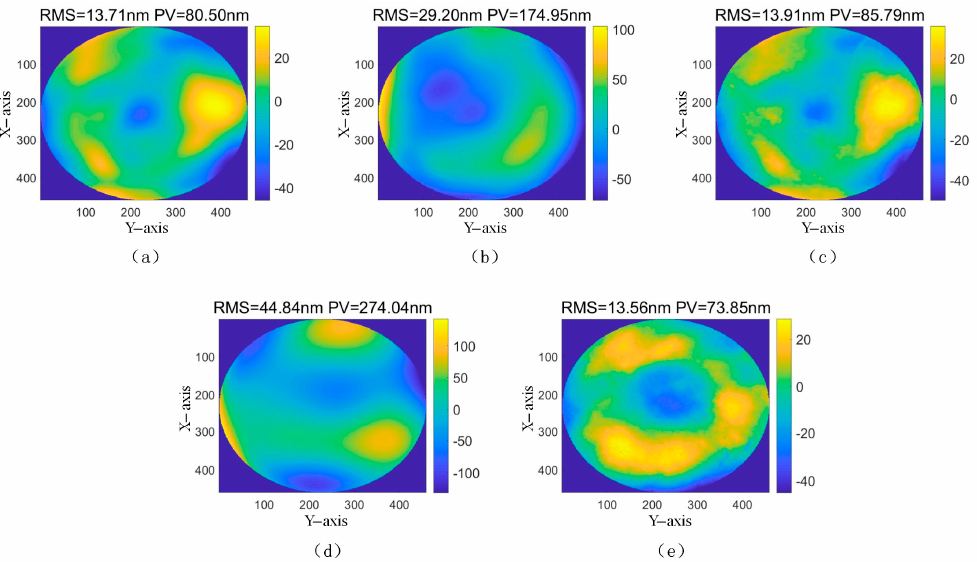
Figure 10. Experiment results of the optical planar element (after removing the first six terms): ( a ) EPCM; ( b ) PM with systematic errors; ( c ) PM after eliminating systematic errors; ( d ) MPMD; ( e ) Interferometer. Table 3. Experiment results of the planar window glass and the optical planar element. Unit: nm.